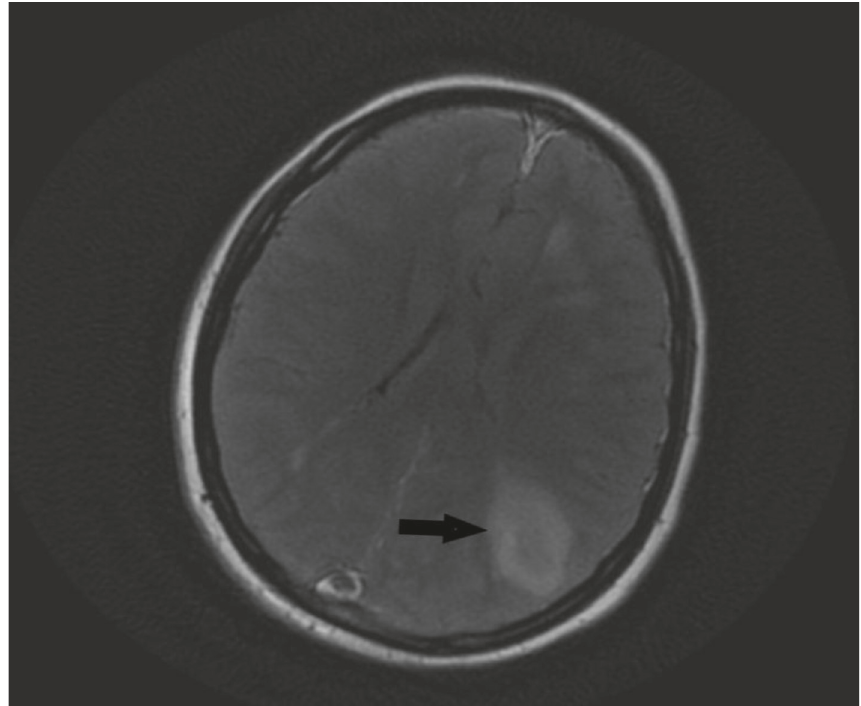
Figure 2: Magnetic resonance imaging (MRI) of the brain with contrast, T2 flair showing left parietal lobe hemorrhagic infarct